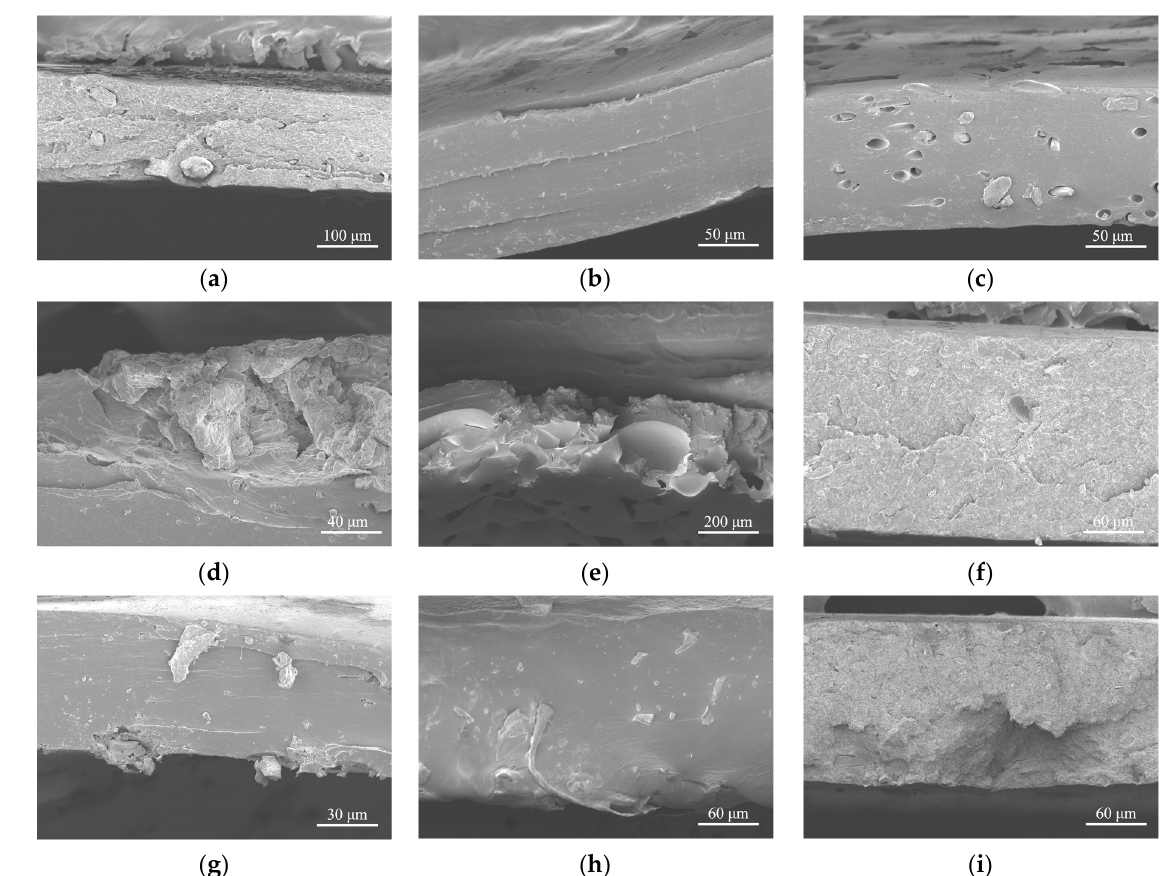
Figure 6. The SEM images of fractograph of pure and functional PU films: ( a ) F1 (WD = 5.7 mm, EHT = 2.0 kV); ( b ) F2 (WD = 6.9 mm, EHT = 2.0 kV); ( c ) F3 (WD = 5.9 mm, EHT = 2.0 kV); ( d ) F4 (WD = 7.0 mm, EHT = 2.0 kV); ( e ) F5 (WD = 6.9 mm, EHT = 2.0 kV); ( f ) F6 (WD = 5.9 mm, EHT = 2.0 kV); ( g ) F7 (WD = 6.1 mm, EHT = 2.0 kV); ( h ) F8 (WD = 7.1 mm, EHT = 2.0kV); ( i ) F9 (WD = 7.0 mm, EHT = 2.0 kV).